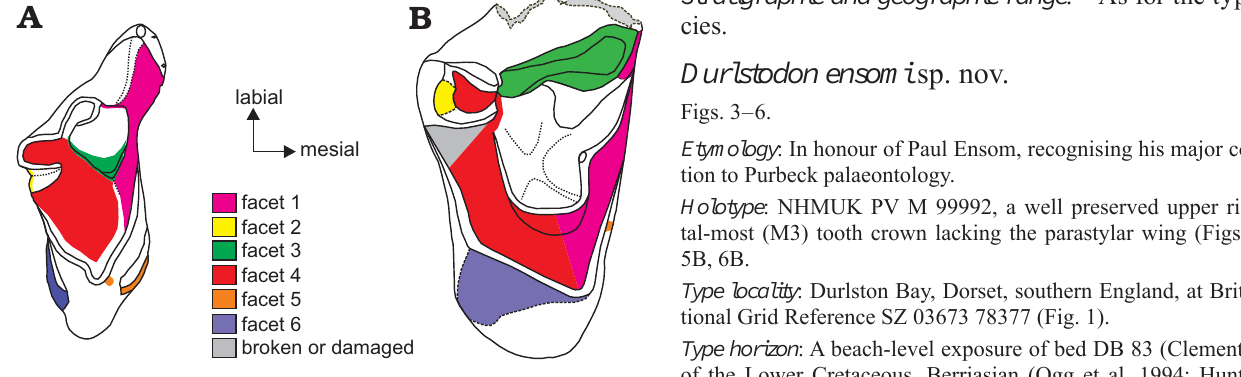
Fig. 6. Explanatory drawing of studied specimens of eutherian mammal teeth from the Berriasian Purbeck Group of Dorset, southern England; in occlusal view showing wear facets described in the text (from Crompton 1971). A . Durlstotherium newmani gen. et sp. nov., NHMUK PV M 99991. B . Durlstodon ensomi gen. et sp. nov., NHMUK PV M